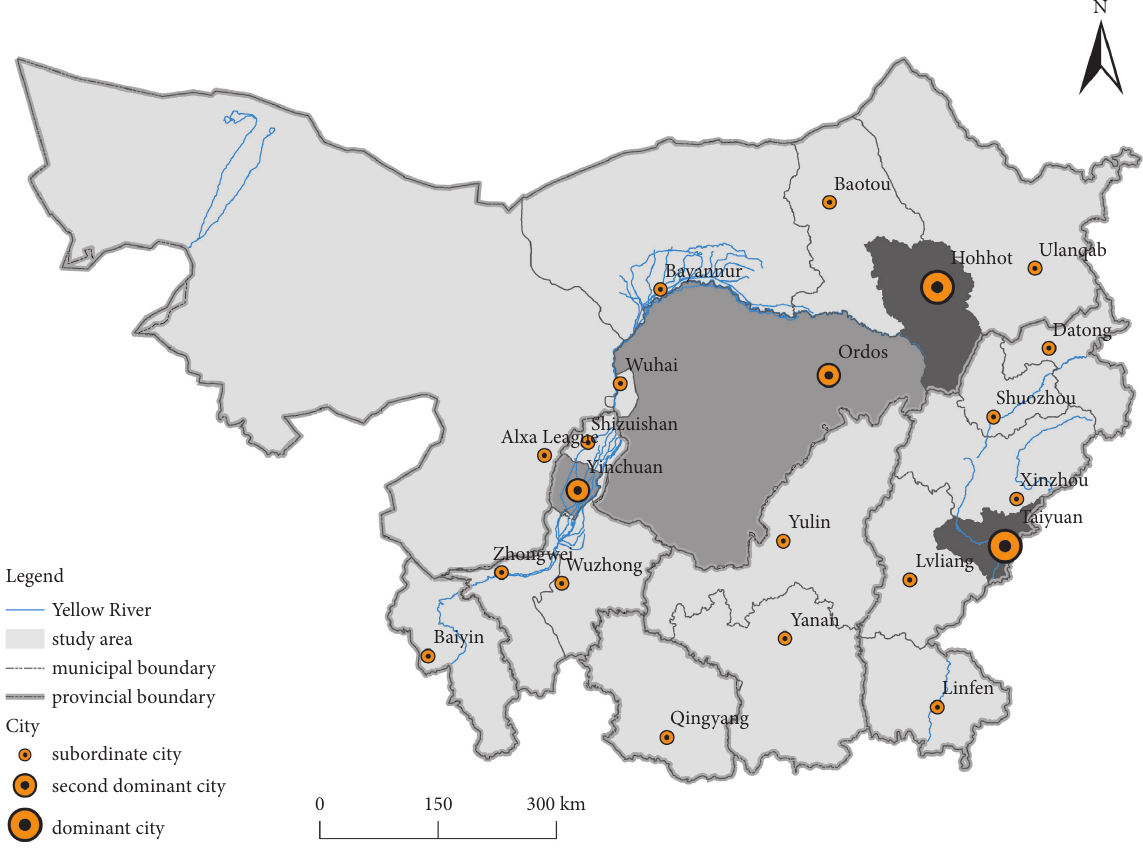
Figure 4: Spatial hierarchy of the UAYB by dominant flow